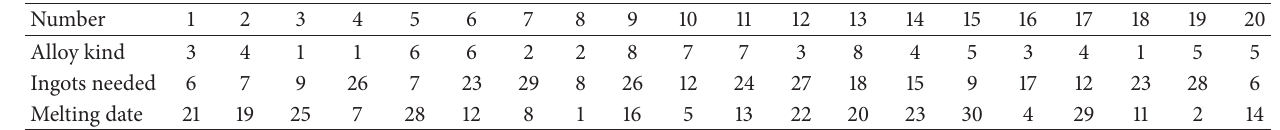
Table 3: Order data of instance 20-1.